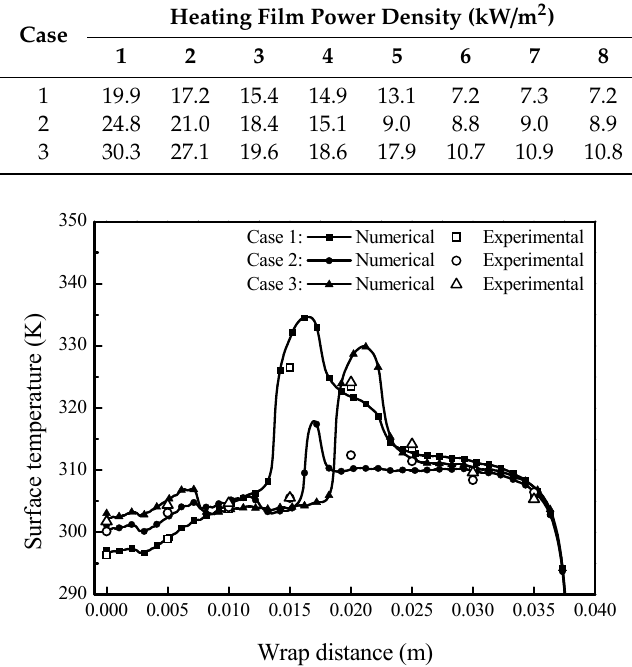
Table 4. Heating power distributions for the surface temperature validation. Case